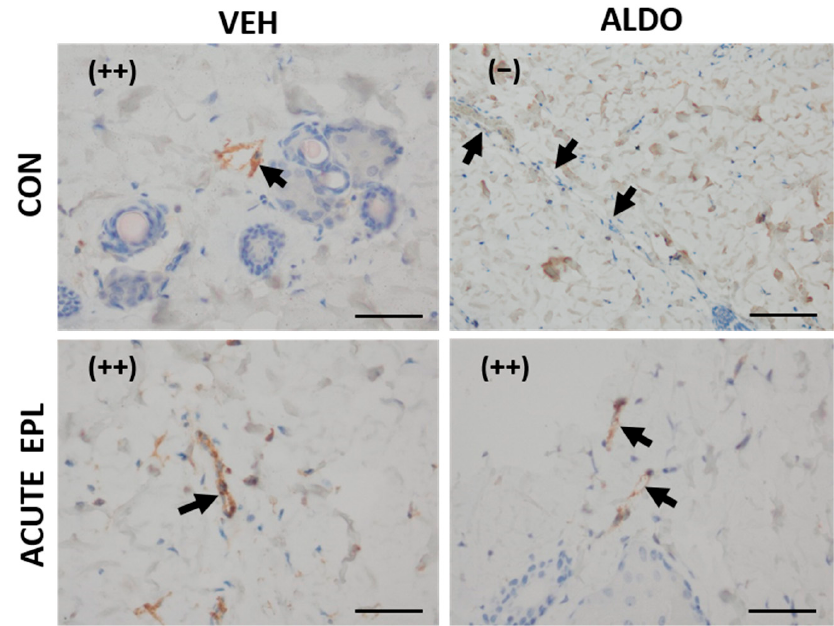
Figure 5. ALDO induced endothelial exocytosis of vWF in skin blood vessels. n = 8; n for each group is the number of skin samples, not the number of animals; 16 rats were used in this experiment; immunohistochemical staining for von Willebrand factor showed a lack of staining ( − ) in ALDO-injected skin. Acute EPL administration restored the vWF staining strength (++) in ALDO-injected skin. ALDO—aldosterone; CON—5% gum arabic solution; EPL—eplerenone; VEH—ALDO solvent. ( − )—lack of staining; (++)—moderate staining. Arrows point to blood vessels. Scale bars: 50 μ m.